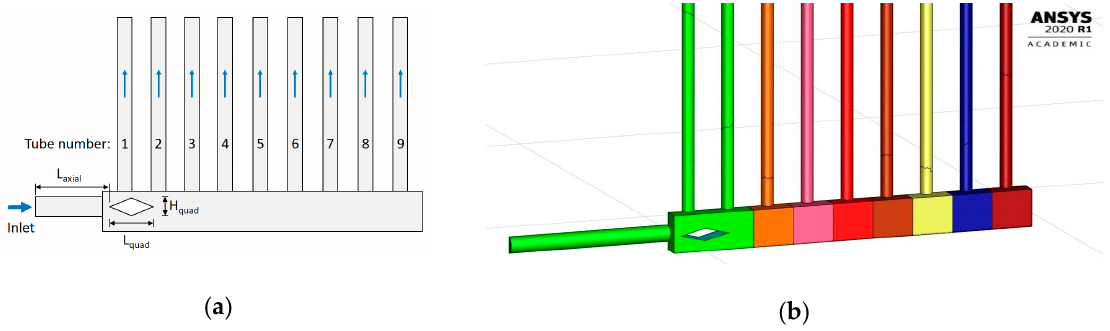
Figure 4. Novel design concept in a dividing manifold: ( a ) Schematic; ( b ) 3D model. The length, height, and installation location in the inlet region of the header were set as the major